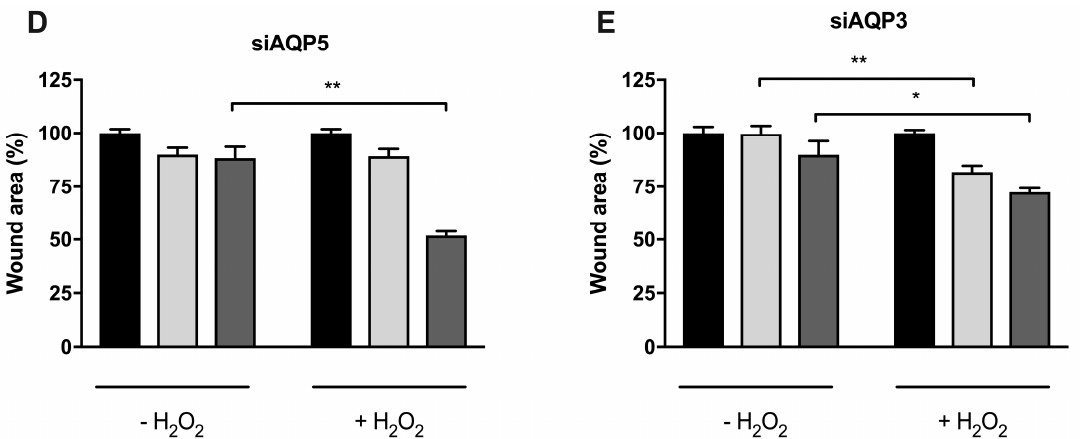
Figure 7. Cell migration of BxPC3 cells upon oxidative stress. ( A ) Cell migration of cells transiently transfected with corresponding siRNA (control, AQP3, and AQP5) in normal media. Significance levels: ns, non-significant, * p < 0.05, ** p < 0.01, *** p < 0.001 vs. time 0. ( B ) Cell viability determined by MTT assay after cell exposure to a range of H 2 O 2 concentrations for 24 h and 72 h. ( C ) Cell migration of control cells, ( D ) cells silenced for AQP5, and ( E ) cells silenced for AQP3, before and after addition of 100 µ M H 2 O 2 . Wound repair was monitored at 12 h and 24 h under light microscopy, and cell migration was normalized to original wound area at time 0. Results are mean ± SEM of triplicate experiments. Significance levels: * p < 0.05, ** p < 0.01 vs. non-treated cells.